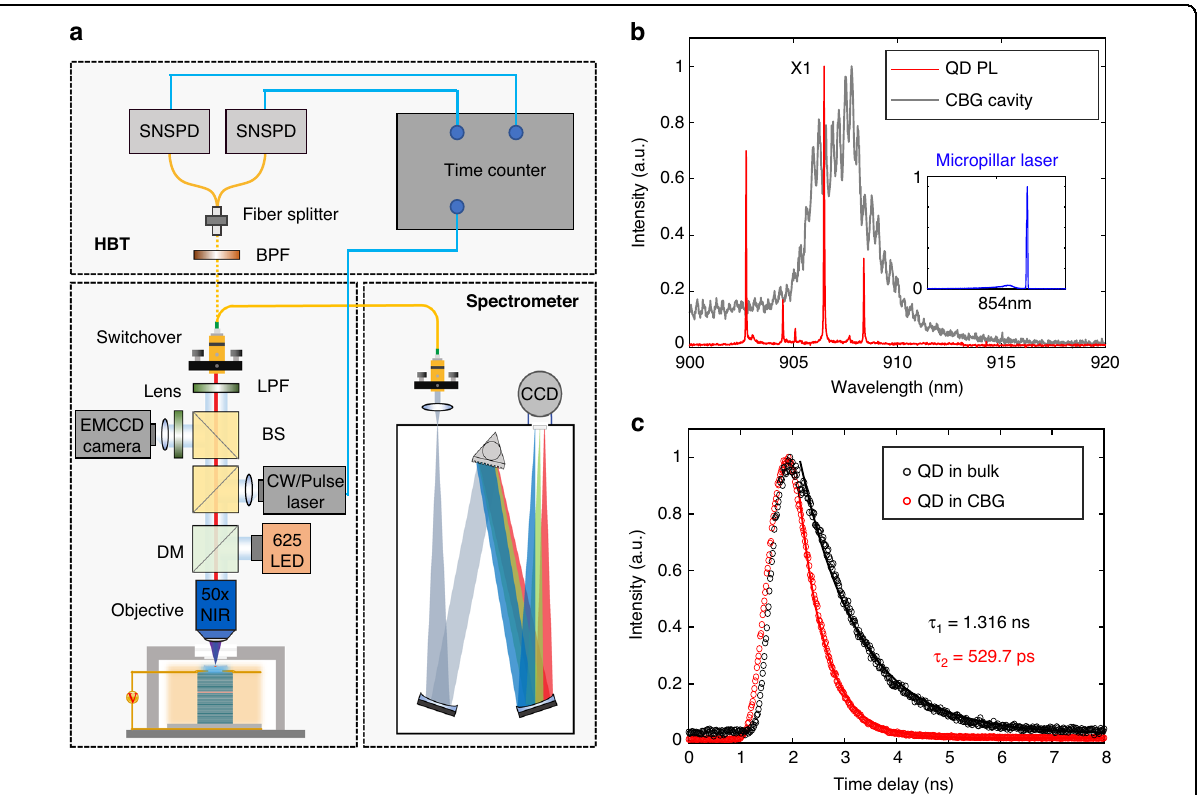
Fig. 4 Experiment setup and device characterizations. a Schematic of the experiment setup. BS: beam splitter. LPF long-pass fi lter, DM dichroic mirror, BPF band-pass fi lter, SNSPD superconducting nanowire single-photon detector. b PL spectrum of excitonic states associated with a single QD (red line) and the cavity mode of CBG (black line). c Comparison of the lifetimes for the QD coupled to the CBG (red) and a QD in bulk